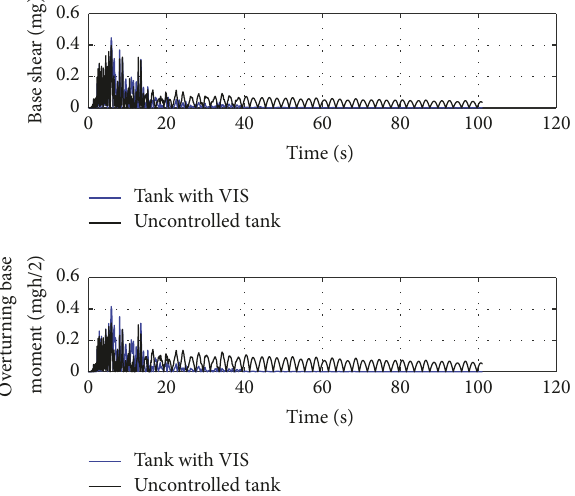
Figure 17: Base shears and overturning base moments of the tank with the VIS and the uncontrolled tank under the excitation of the Kobe earthquake.